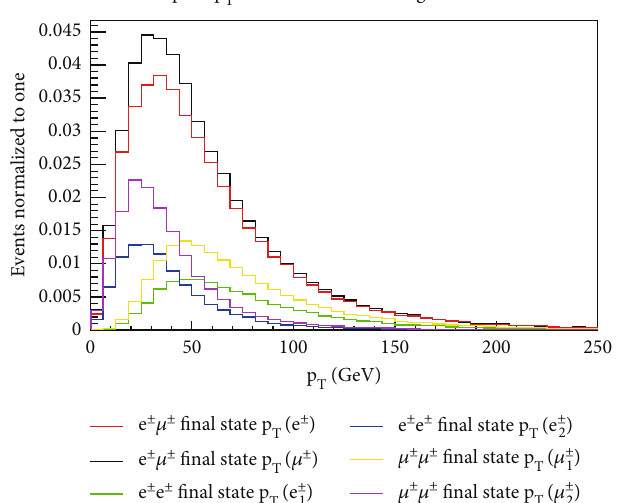
Figure 6: For the signal process, lepton p distributions e ± e ± , μ ± μ ± , e ± μ ± event regions: histogram clearly shows that e ± μ ± fi nal state is more T favorable. The e ± μ ± pair comes from the disintegration of W ± pairs which have about 80GeV rest mass. Hence, that energy and momentum shared by fi nal particles give a peak around 40GeV with boosted behavior. However, the same fl avor fi nal states shows an asymmetry particle which gives a gap between fi rst and originates from the following reasons: detector always discriminates lower and higher p T second highest p object. Nevertheless, they all have boosted behavior and give peaks close to 40GeV as well. T